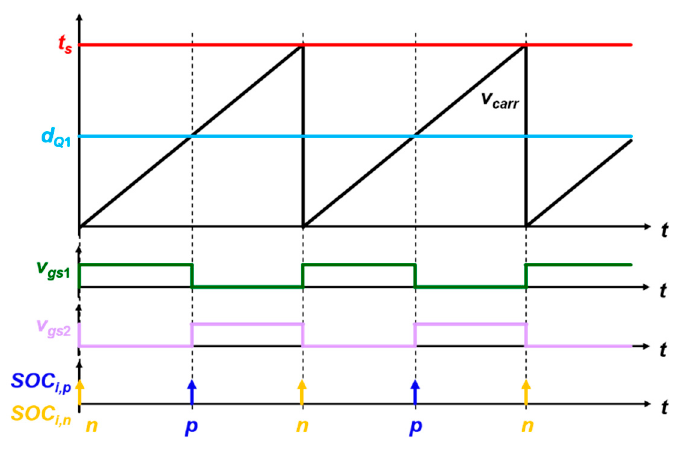
Figure 11. VFVDPWM operating timing.